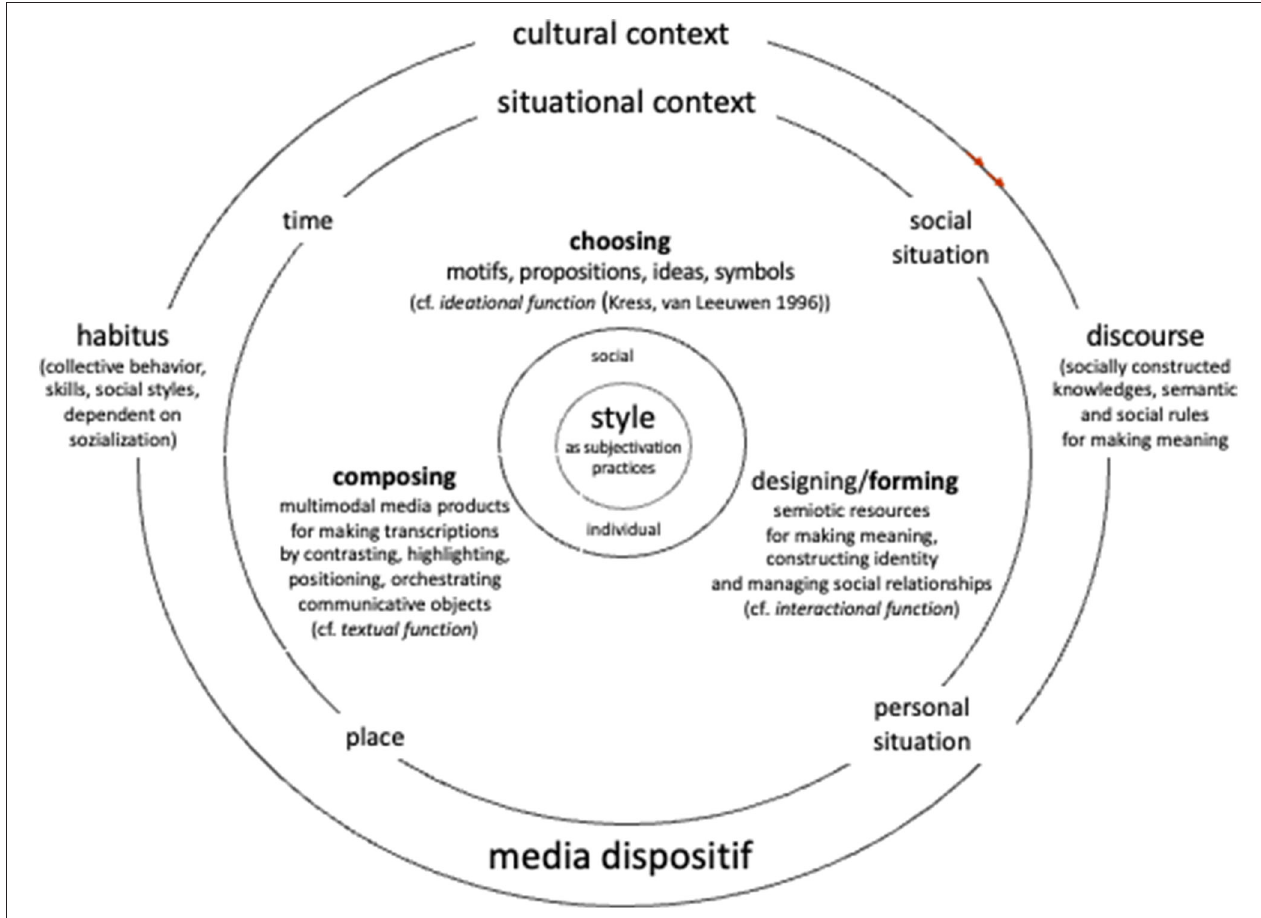
FIGURE 1 | Style practices as multimodal construction of identity in the form of subjective choosing , forming , and composing semiotic resources (cf. Meier, 2014).